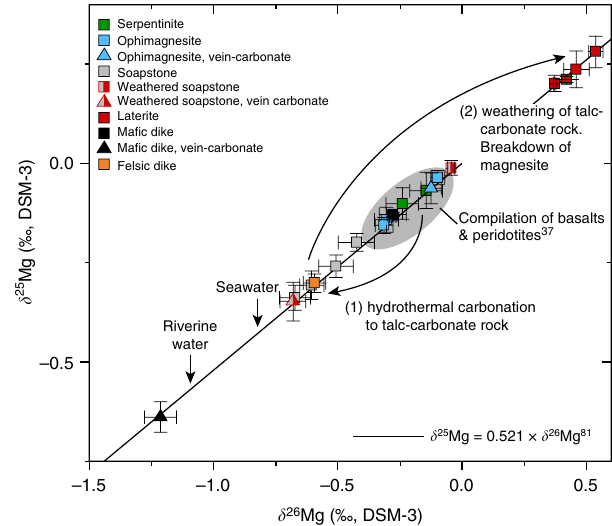
Fig. 7 Mg isotope systematics in ultrama fi c alteration and weathering systems. Three-isotope plot showing Mg isotope ratios of bulk rock samples from the SGC drill core through weathered (laterite) and hydrothermally carbonated (talc-carbonate) serpentinite. Mg isotope ratios of the precursor serpentinite are consistent with the compilation of pristine ultrama fi c and ma fi c rocks 37 . Talc-carbonate altered rocks are enriched in 24 Mg, which is interpreted to re fl ect addition of 24 Mg during open system hydrothermal alteration. Preferential breakdown of magnesite in laterite weathered parts of the drill core results in an overall depletion in bulk rock Mg and effective removal of 24 Mg. The laterite Mg isotope ratios are controlled by high δ 25,26 Mg values of relict talc and are consistent with the composition of talc elsewhere 36 . δ 25 Mg and δ 26 Mg values are consistent with mass-dependent Mg isotope fractionation [81]. Error bars re fl ect the 2 σ standard deviation. Data are listed in Supplementary Table